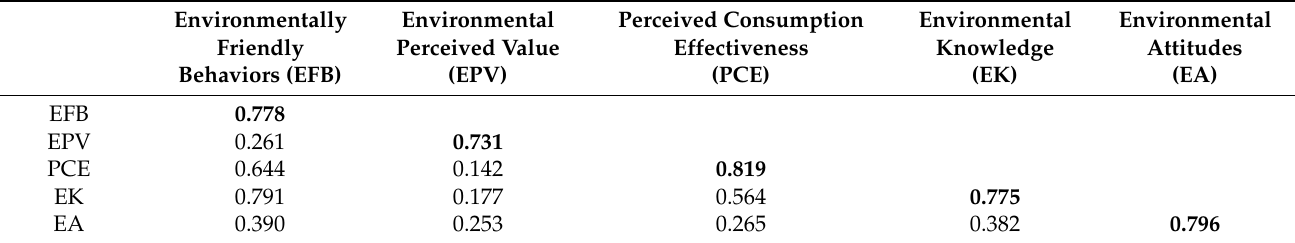
Table 4. Squared correlation coefficients and average variance.